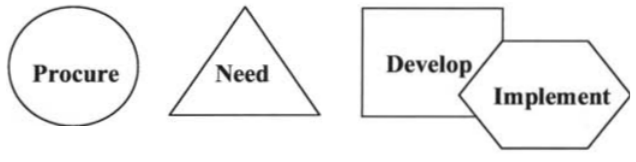
Figure 6: The Aspirational